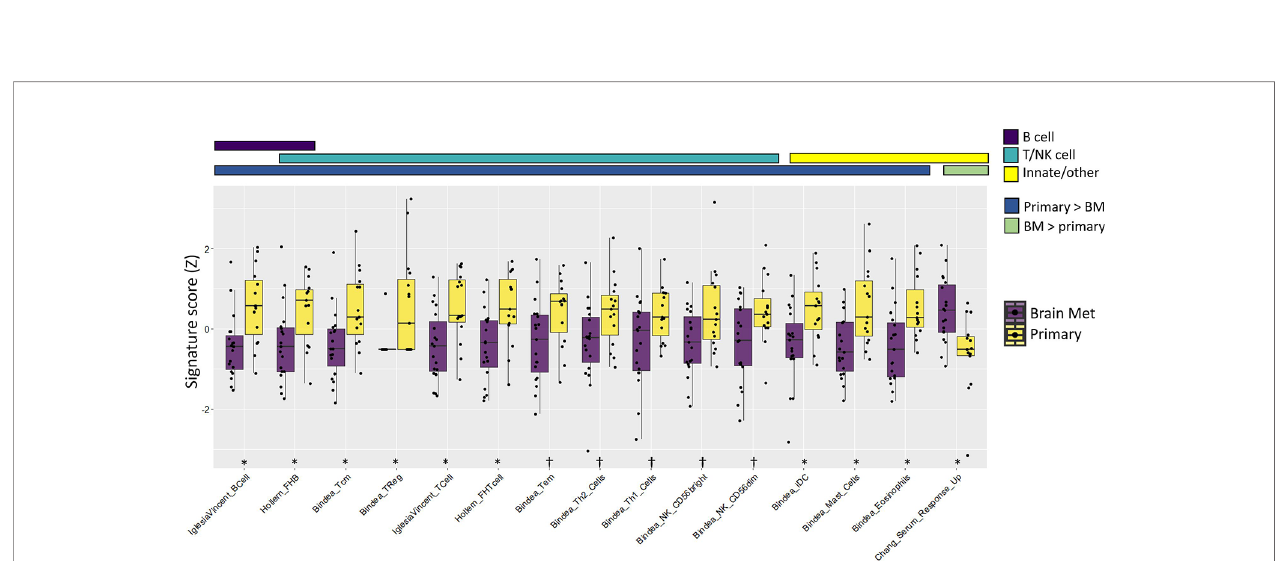
FIGURE 3 | Immune gene signature metagene analysis showed an overall immune cell de fi cit in BrM relative to primary triple-negative breast cancer. The colored bars above the plot indicate both the immune cell category assigned to the respective signatures and whether the signatures were increased/decreased in the primary tumor relative to BrM. Wilcoxon rank-sum test was performed on Z-transformed signature scores to determine the statistical signi fi cance after false discovery rate correction. Signi fi cance codes: † q < 0.1, * q <